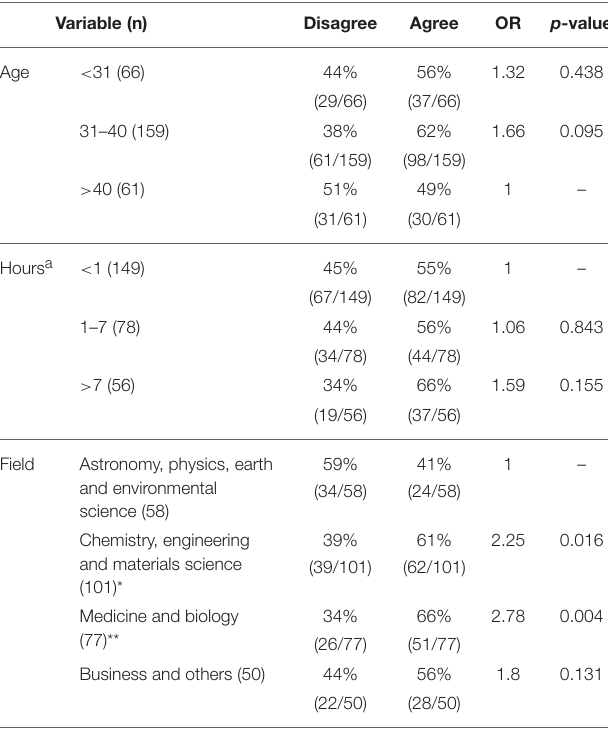
TABLE 1 | Researcher’s views on funding research for the scientific investigation of